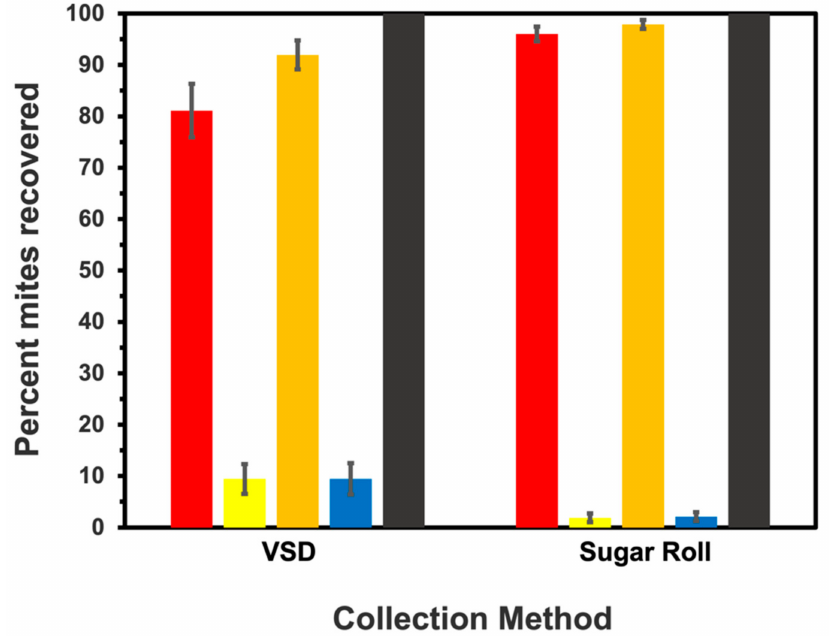
Figure 4. The percentage (mean ± standard err (se)) of Varroa dislodged from honey bee samples using the Varroa Shaking Device (VSD) and the sugar roll method. The efficiency was estimated for first (red bar) and second (yellow bar) shaking periods, followed by the residual percentage collected from visual inspection of bees after the second shaking period (blue bars). The sum of percent recovery between the first and second shaking period and the second shake period and final visual inspection of bees for residual mites are given by orange and black bars,